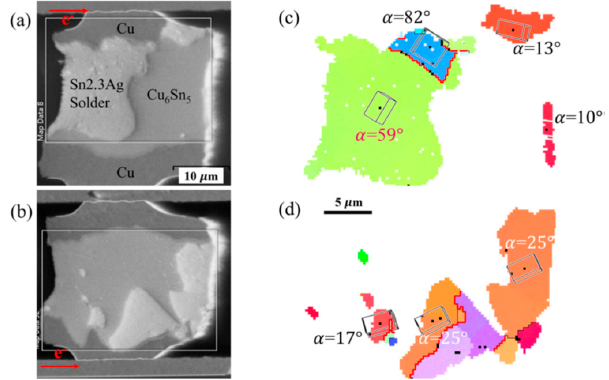
Figure 11. Rapid formation of Cu-Sn IMC in low- α -angle grains after current stressing of 4 × 10 4 A/cm 2 and 165 °C for 65 h. SEM image for the micro-bump ( a ) with a downward electron flow and ( b ) with upward electron flow. ( c ) Corresponding OIM for the micro-bump in ( a , d ) corresponding OIM for the micro-bump in ( b ). Red arrows represent direction of DC current. Reprinted with permission from Ref. [56] Copyright 2017